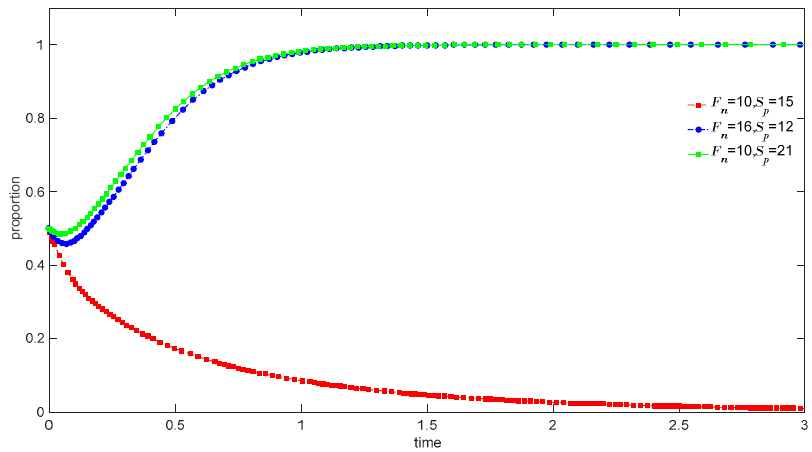
Figure 14. The sensitivity of subsidies and penalties for processor.